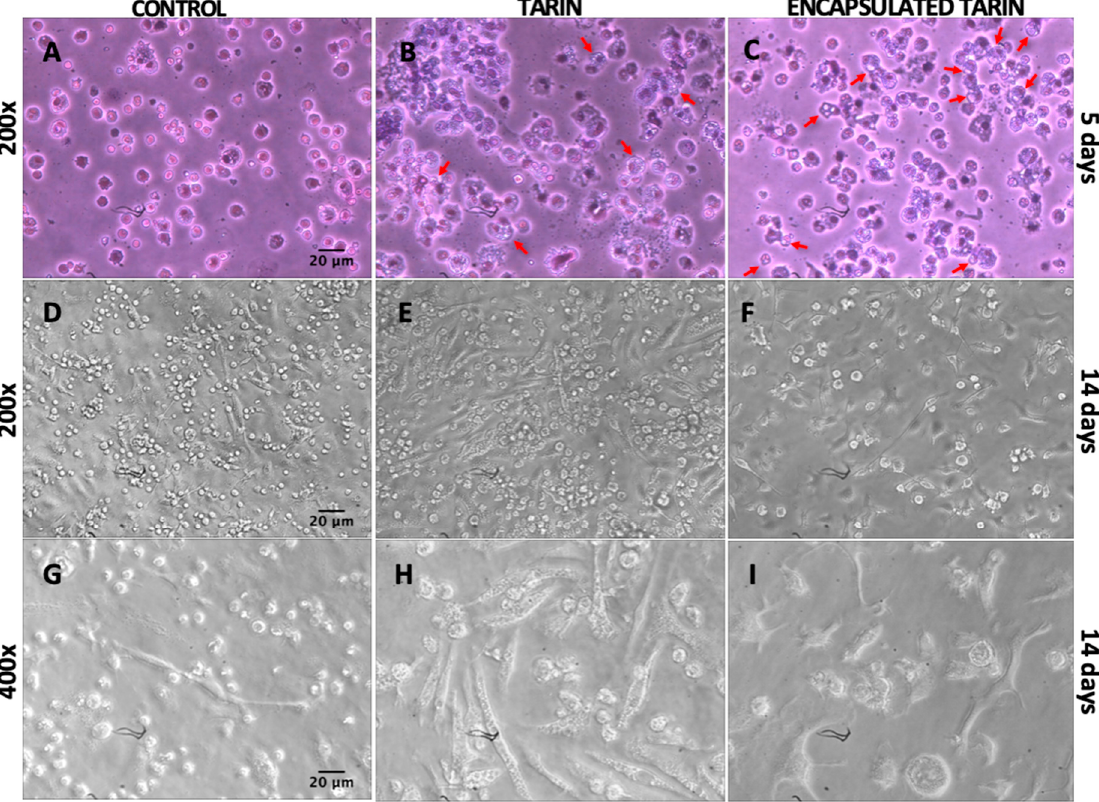
Figure 5. Morphological characteristics of mice bone marrow cells treated with free and encapsulated tarin. Bone marrow cells were harvested from cultures after 5 ( A – C ) or directly observed from cultures after 14 days ( D – I ). Five-day culture cells were subjected to cytospin and stained with Grunwald-Giemsa. Red arrows indicate the presence of vesicles inside the cytoplasm. Photographs were recorded at 200 × and 400 ×